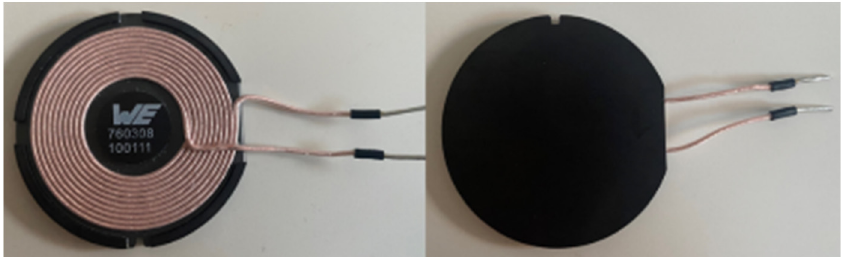
Figure 12. Picture of the Transmitter coil 760308100111 from Würth Electronics for the test setup.